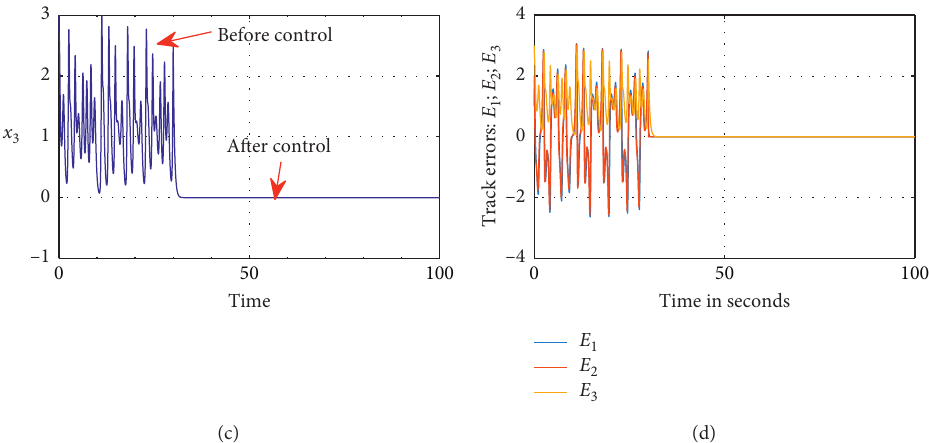
Figure 14: The system response before and after control with x variable x before and after control; (c) the state variable x 2